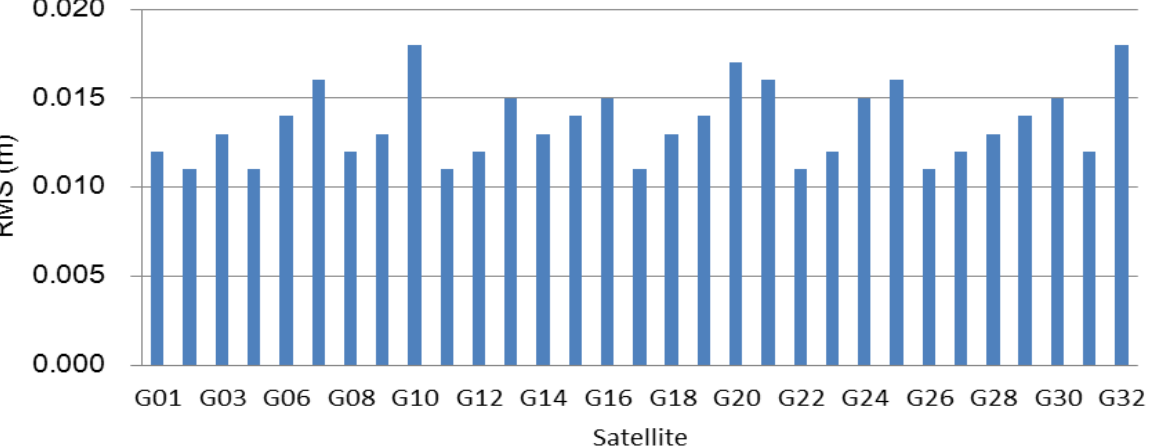
Figure 3. RMSs of the interpolated ionosphere delays for all tracked satellites at the reference epoch.